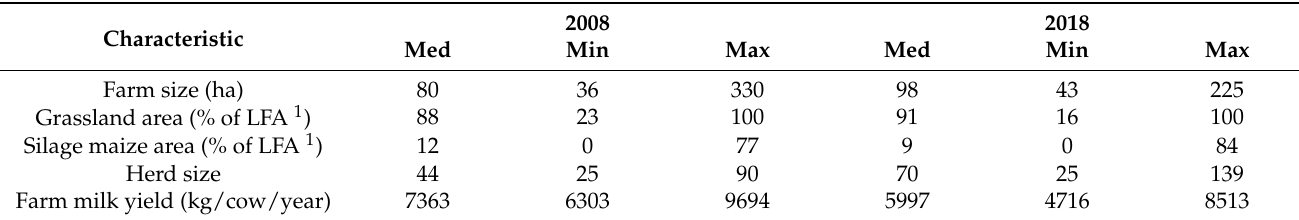
Table 1. Main characteristics (median, minimum and maximum values) of the 14 sampled dairy cattle farms in 2008 and 2018.